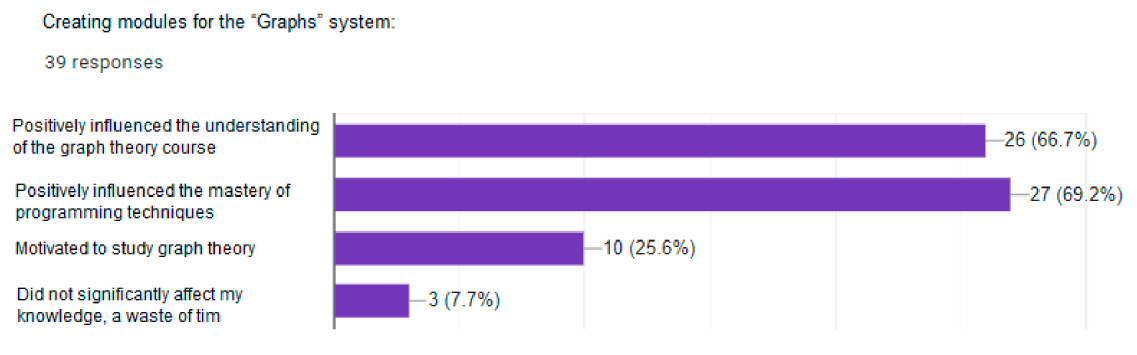
Figure 5. Analysis of the attitude of students to the work of creating modules for the Graphs